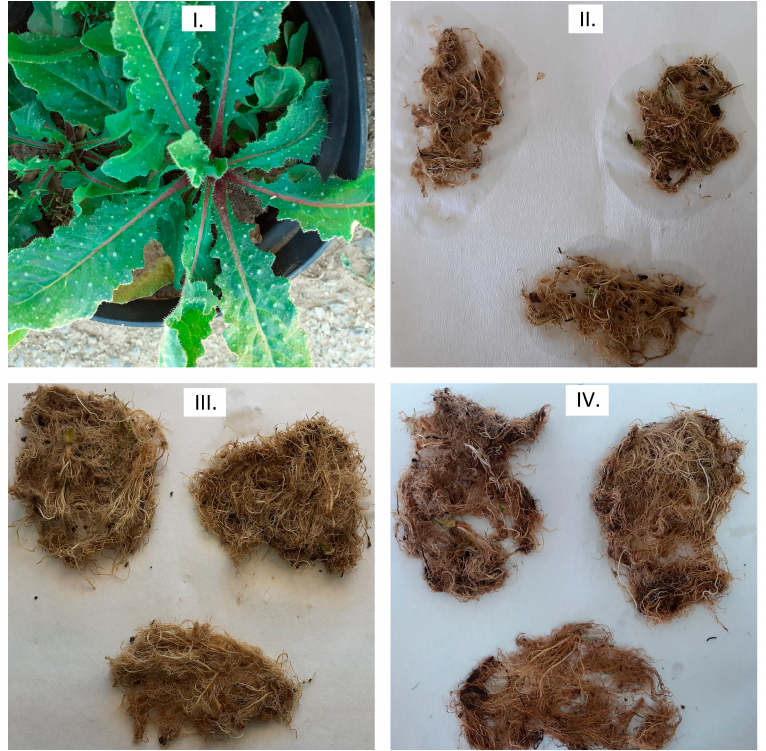
Figure 13. Root growth of bristly oxtongue plants in the control ( II. ), Fert C ( III. ), and Fert D ( IV. ) treatments (12 April 2022). Bristly oxtongue plants at the rosette growth stage on 12 April 2022 ( I. ).